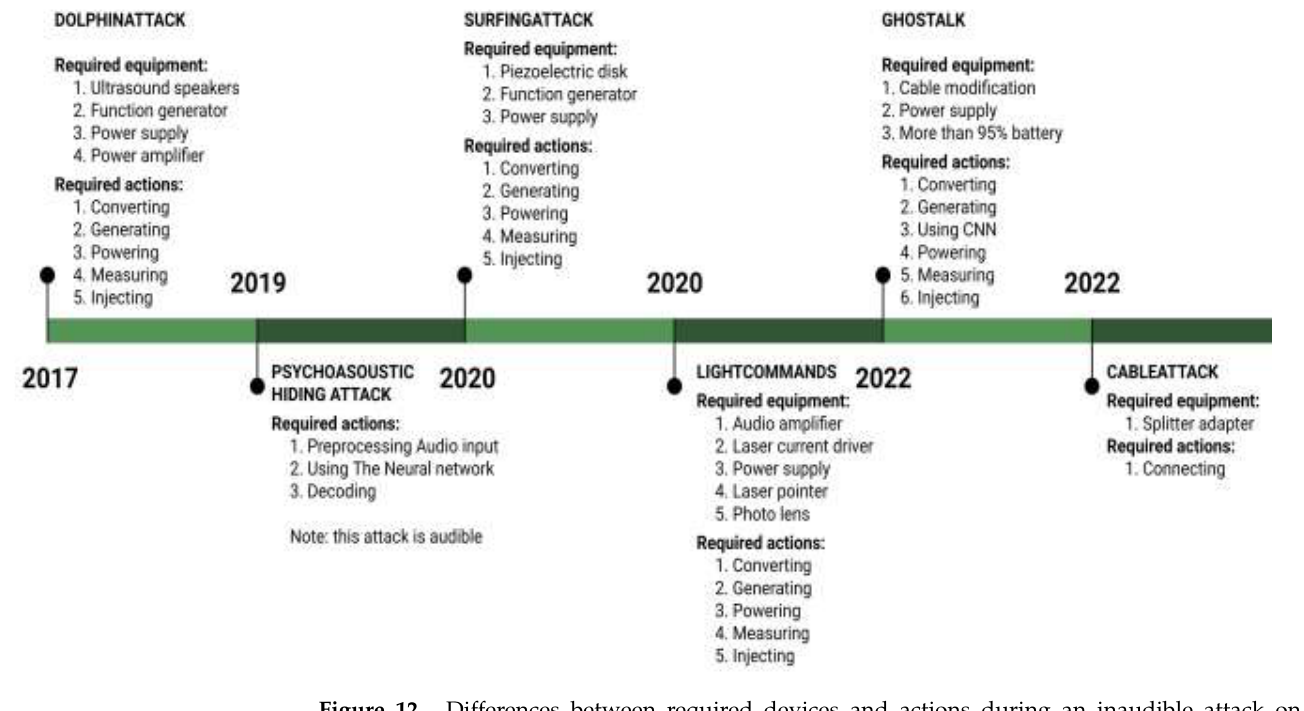
Figure 12. Differences between required devices and actions during an inaudible attack on voice assistants. Figure 13. A connected multifunctional splitter adapter for transmitting audio through the headset and charging connected smartphones.